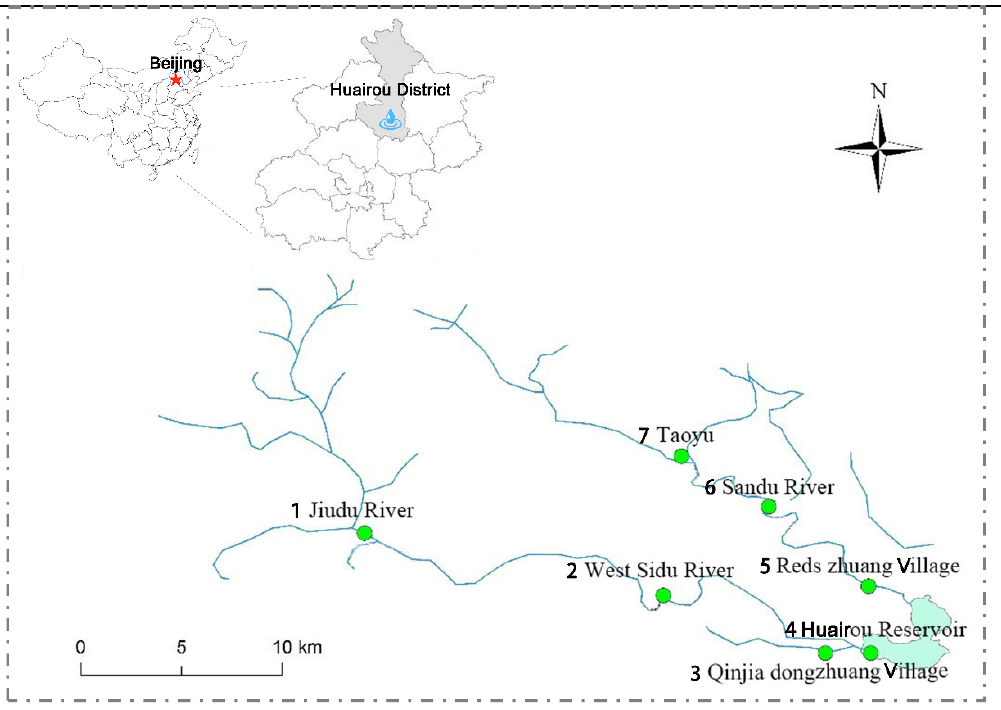
Figure 1. The location of sampling points in an aquatic life reserve of Huairou district, Beijing.